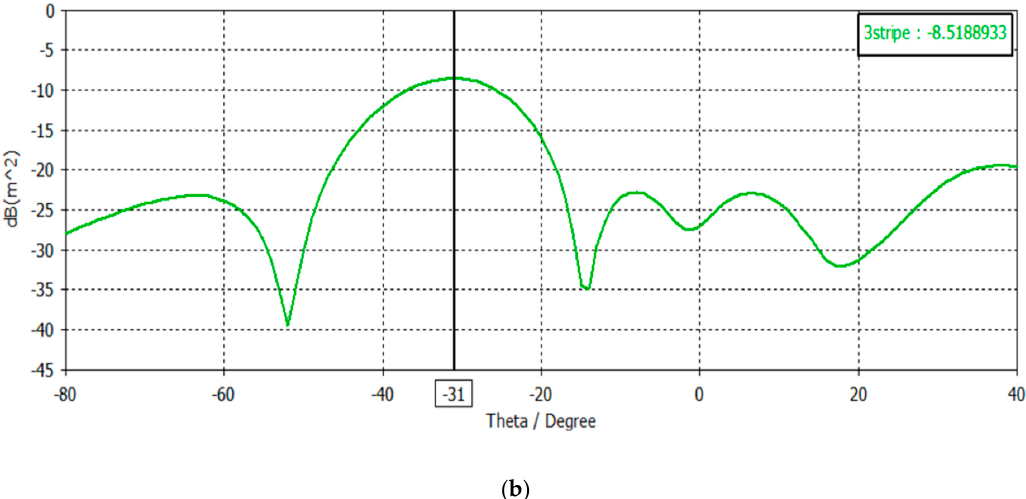
Figure 12. Beam steering far-field radar cross section (RCS) results at 28 GHz in the three-stripe configuration. ( a ) Steering angle simulation results of 12°. ( b ) Steering angle simulation results of 31°.